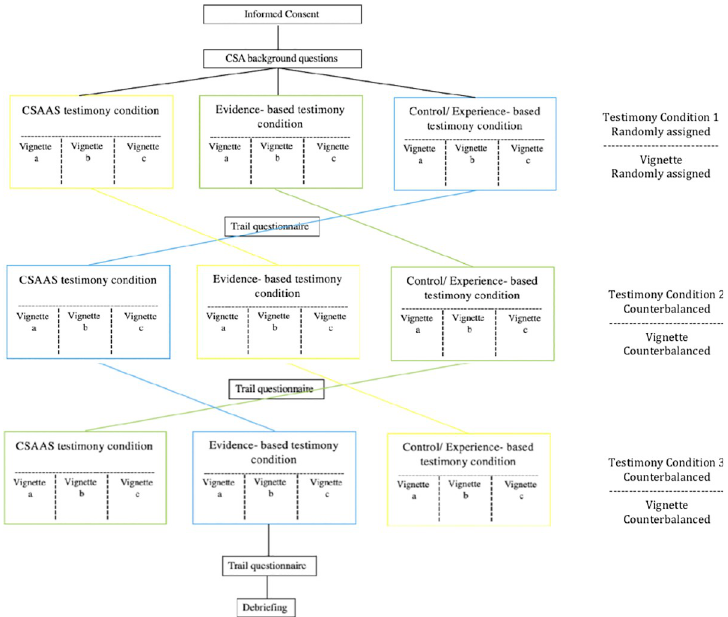
Fig 1. Flow chart for study 1 demonstrating counterbalancing and randomization. The three testimony conditions were counterbalanced, shown in 3 different colors. The three case vignettes (a = fondling, b = exhibitionism, c = pornography) were counterbalanced. The vignettes also included a unique combination of randomly piped in surface-level-details at each instance (i.e. defendant and victim first and last names, age of the victim, race of the victim,